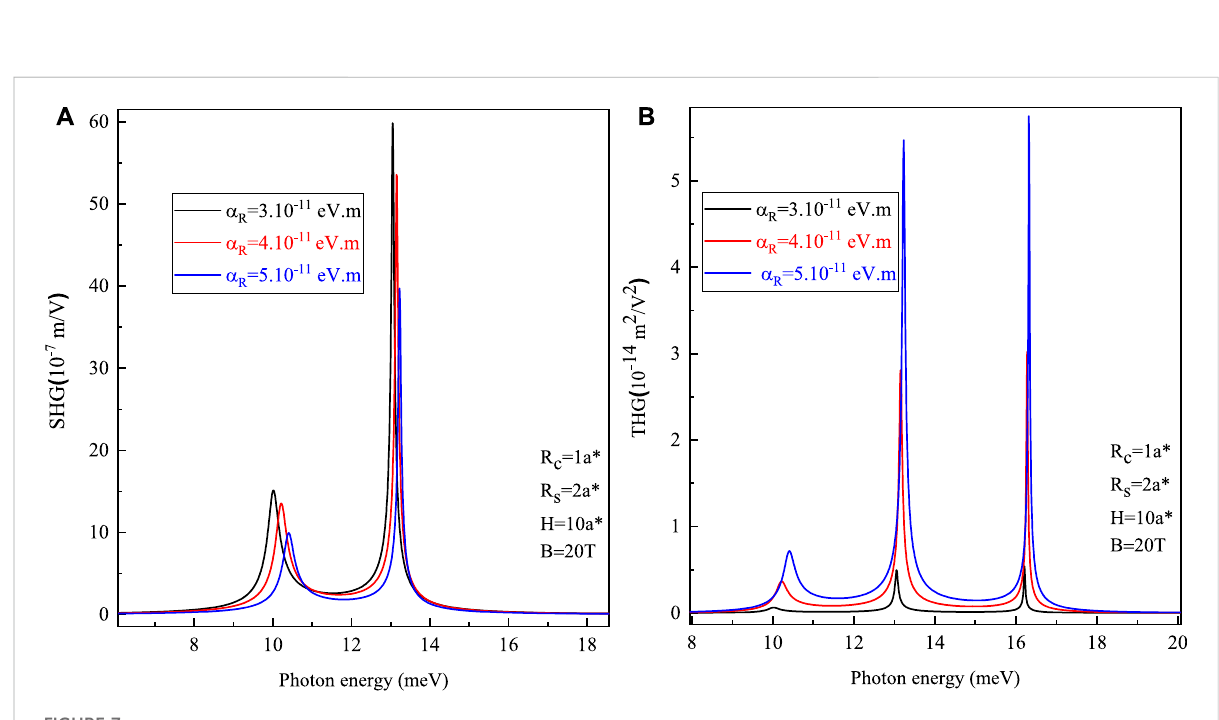
FIGURE 7 The second (A) and the third (B) harmonic generation as functions of incident photon energy with different SOI strengths α R = 3, 4 and 5 × 10 − 11 eV m and R c = 1 a *, R s = 2 a *, H = 10 a